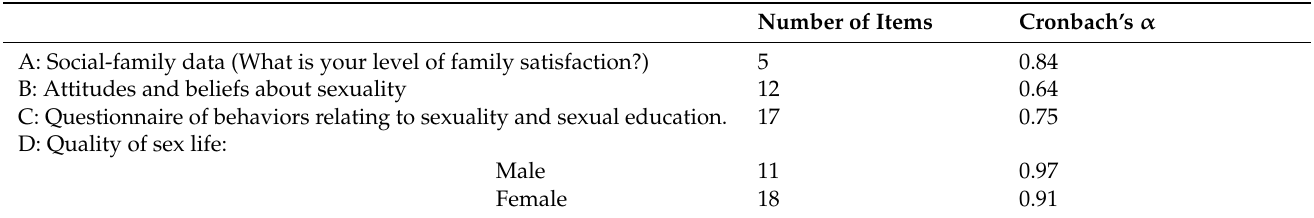
Table 3. Cronbach’s alpha for internal consistency of the Italian version of the SABS.